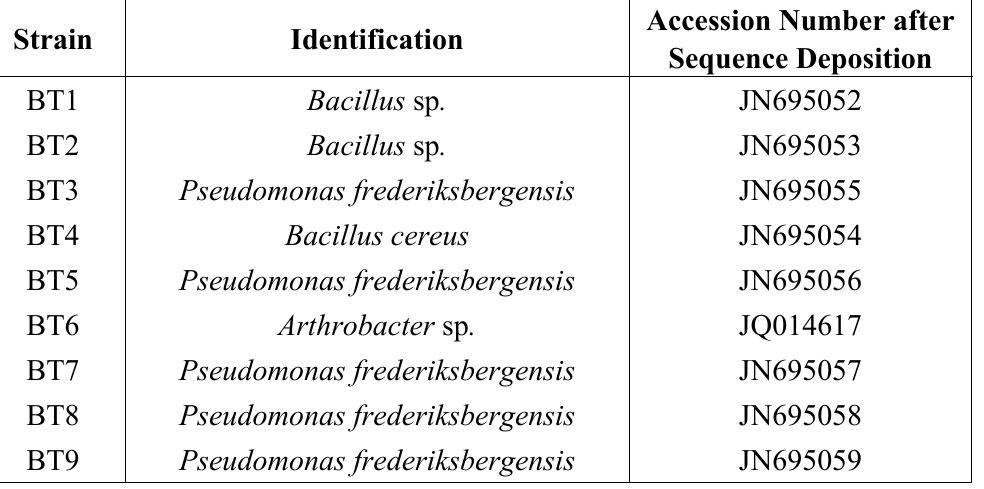
Table 2. Identification of bacterial isolates and their respective accession numbers acquired from